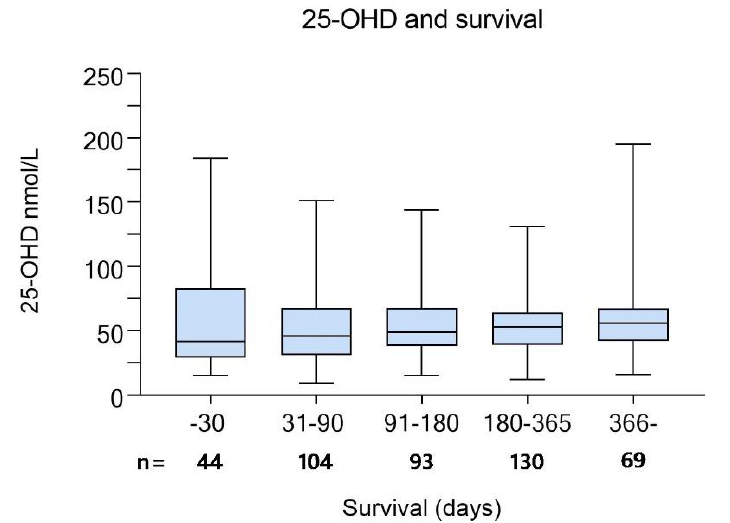
Figure 5. Median 25-hydroxyvitamin D (25-OH) values in nmol/L in deceased patients from the screening cohort ( n = 440) of the ‘Palliative-D’ study included the interquartile range and min-max values. Comparisons between groups was performed with Mann–Whitney U and there were no statistically significant differences between groups.